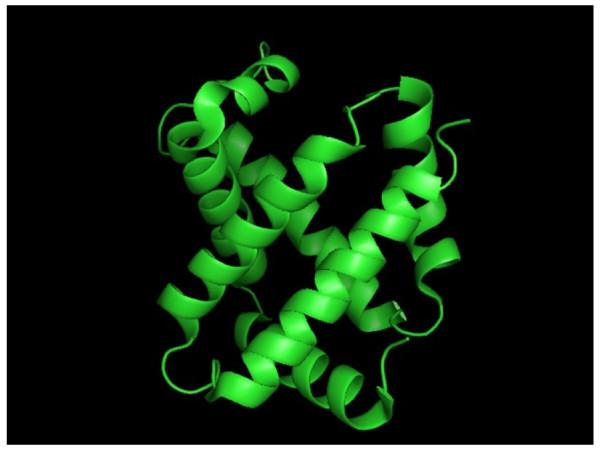
Human hemoglobin (PDB: 2DN2; chain A) [13].